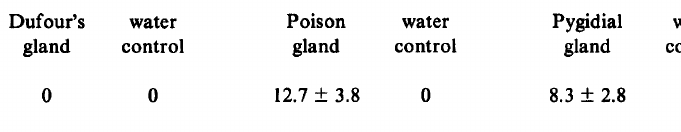
Table 1. Number of workers following artificial trails within 5 min. periods. The means and standard deviations are given. Trails presented at nest entrance (n